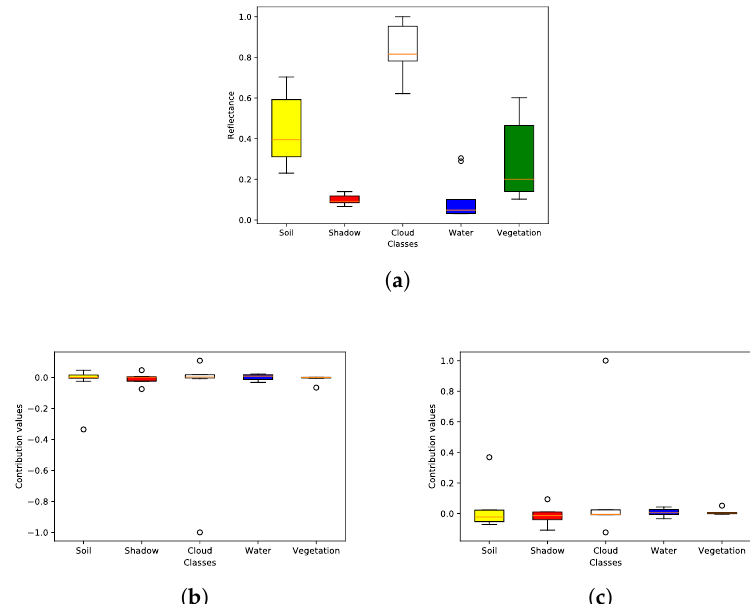
Figure 7. Box and whiskers plots of the behavior of five classes of interest: ( a ) in the original spectral domain, ( b ) the tensor band domain after decomposition for nine bands, and ( c ) the new tensor band domain for five